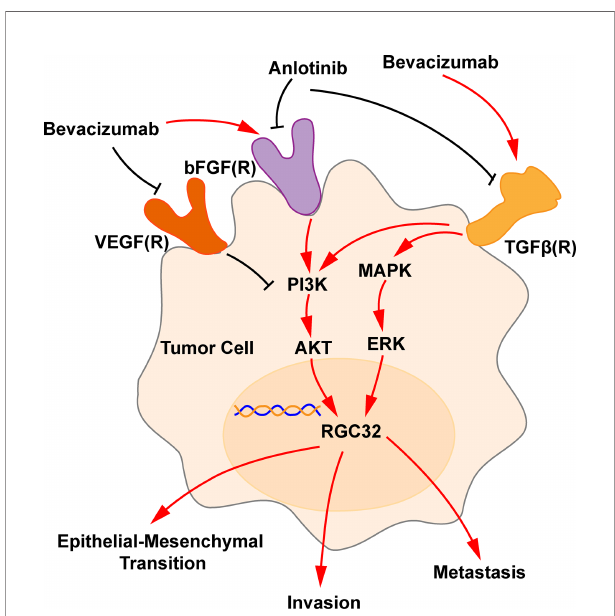
FIGURE 7 | Schematic representation of bevacizumab and anlotinib action in RGC32 signaling pathway. Bevacizumab blocks the VEGF-VEGFR pathway and upregulates the expression of bFGF and TGF b , which upregulates AKT and ERK, and, accordingly, RGC32 expression, which promotes EMT, invasion, and metastasis. Anlotinib downregulates bFGF(R) axis and TGF b , thus downregulates RGC32. A black line indicates a blocking action, and a red line indicates a stimulating